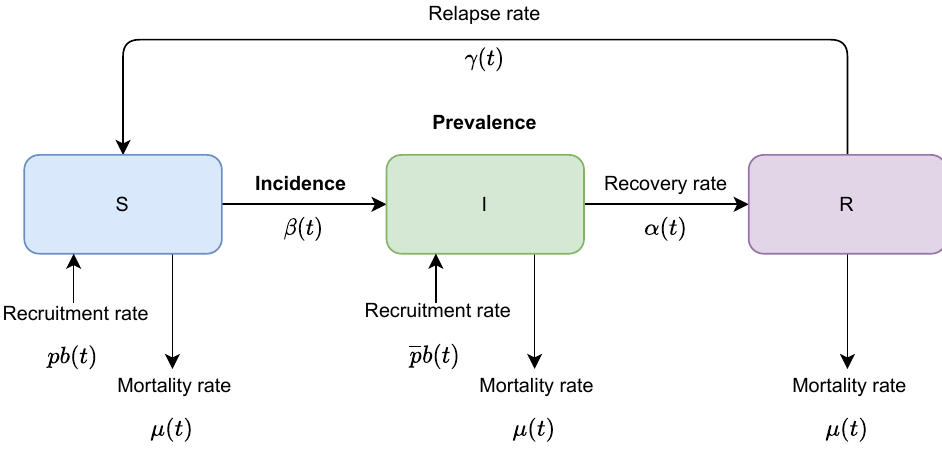
Figure 2. Schematic diagram for the SIR